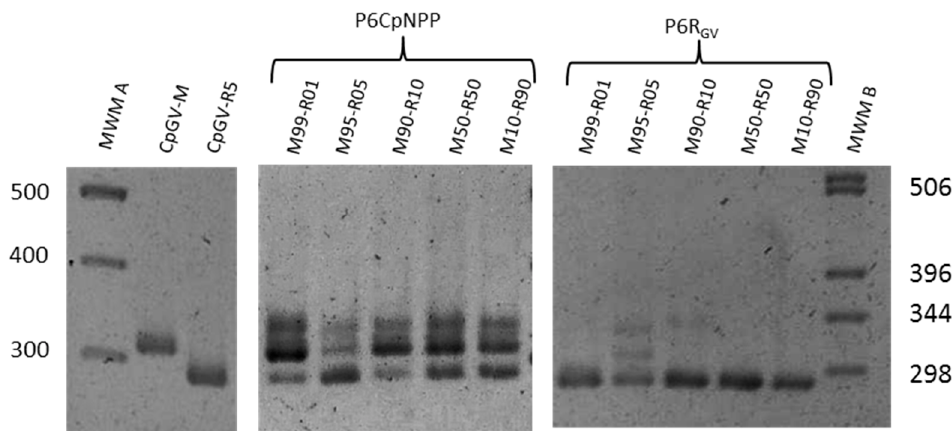
Figure 4. Gel electrophoresis of PCR products revealing the variability on the pe38 region of Cydia pomonella granulovirus populations successively produced during six generations on susceptible (P6 CpNPP ) and resistant (P6 RGV ) insects. CpGV-M and CpGV-R5 are presented as references. MWM A: